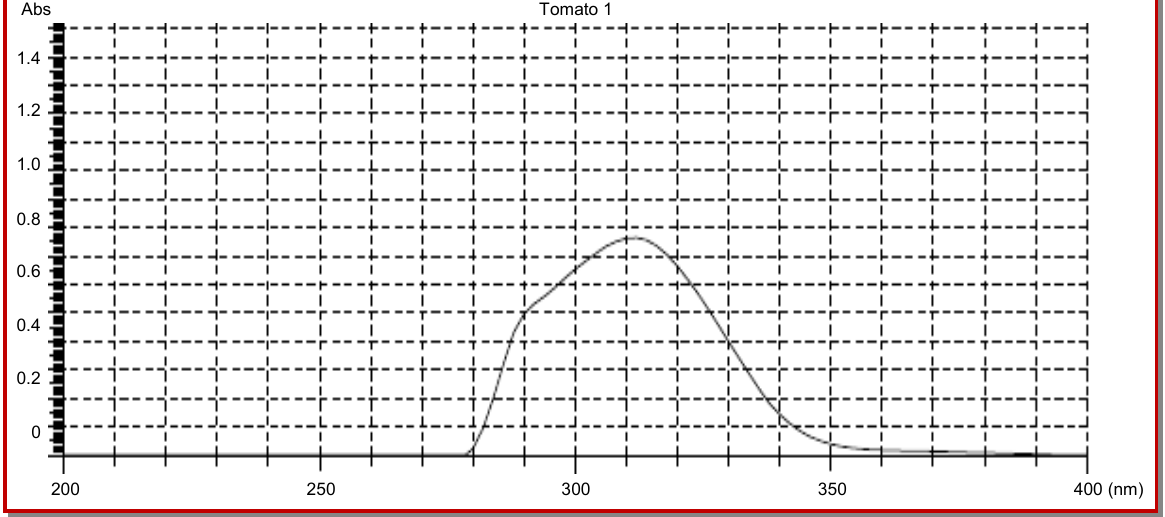
Figure 1: Peak obtained at 310 nm for the standard (Gallic acid)